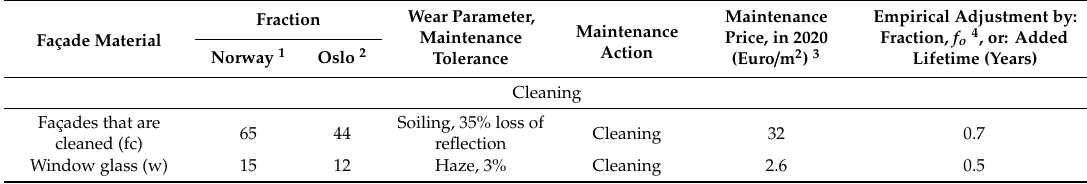
Table 4. Façade materials and fractions, renovation characteristics and empirical adjustments of marginal pollutant e ff ects for the Norwegian and Oslo